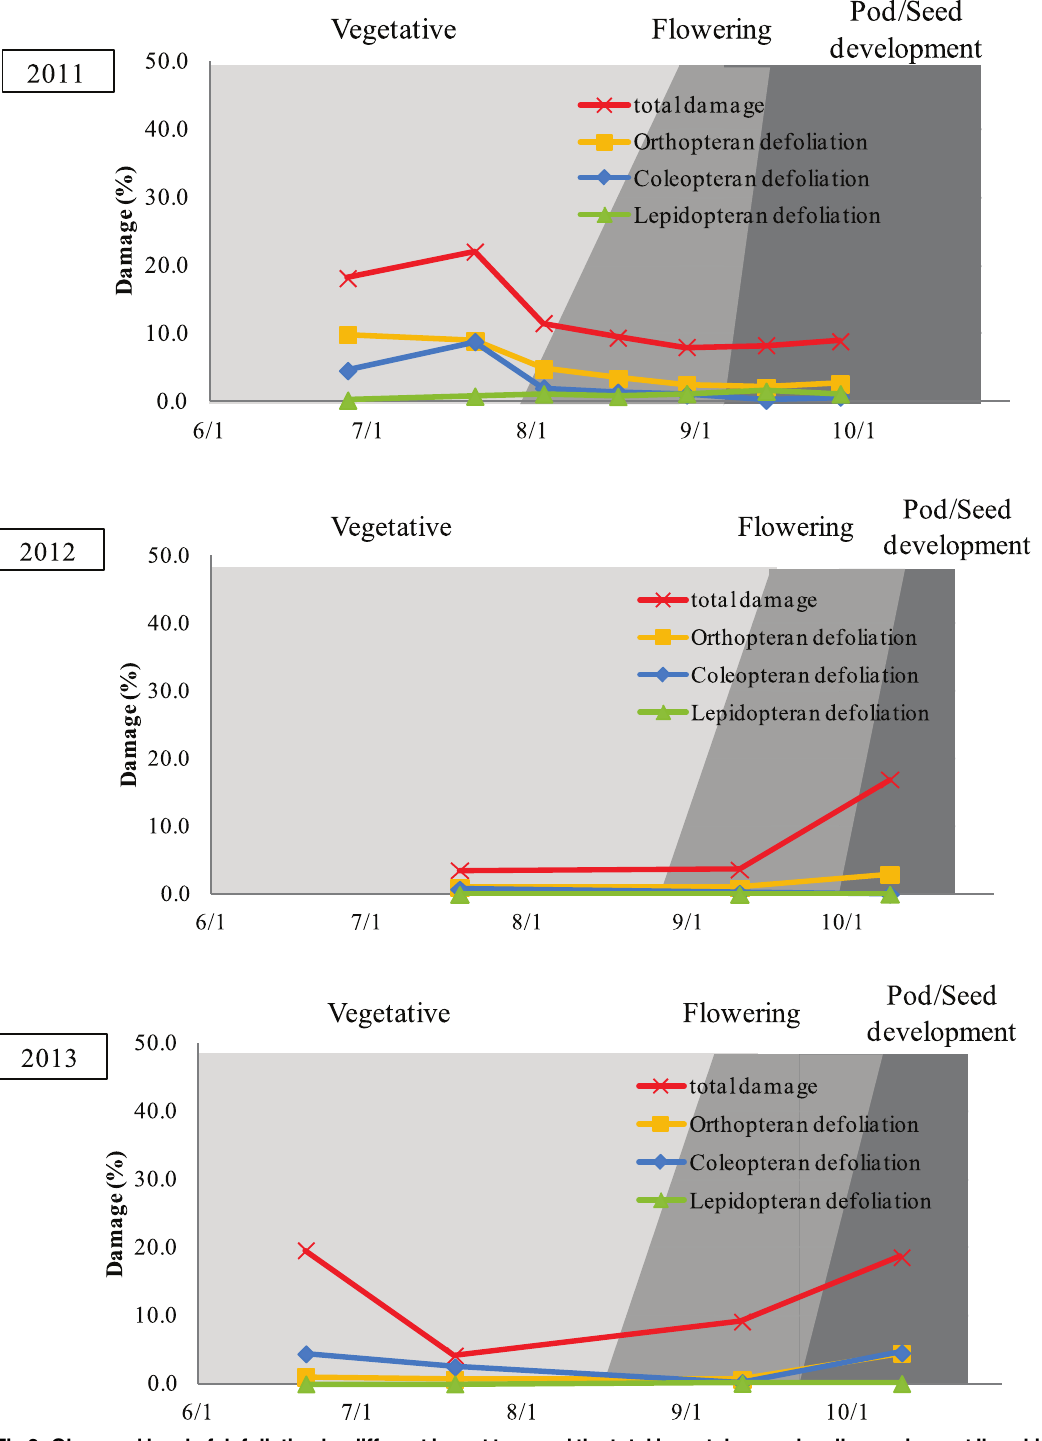
PLOS ONE | DOI:10.1371/journal.pone.0151237 March 10,